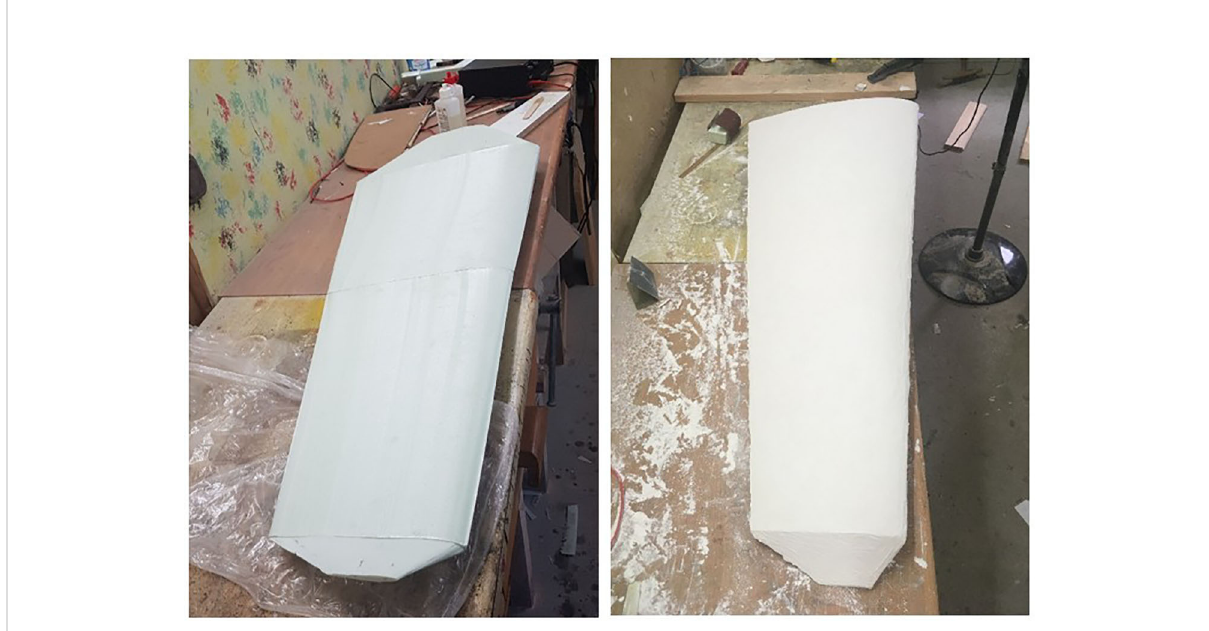
FIGURE 7 Foam wing glued together after manufacturing the single parts. In the right picture the application of the fi ller coat is